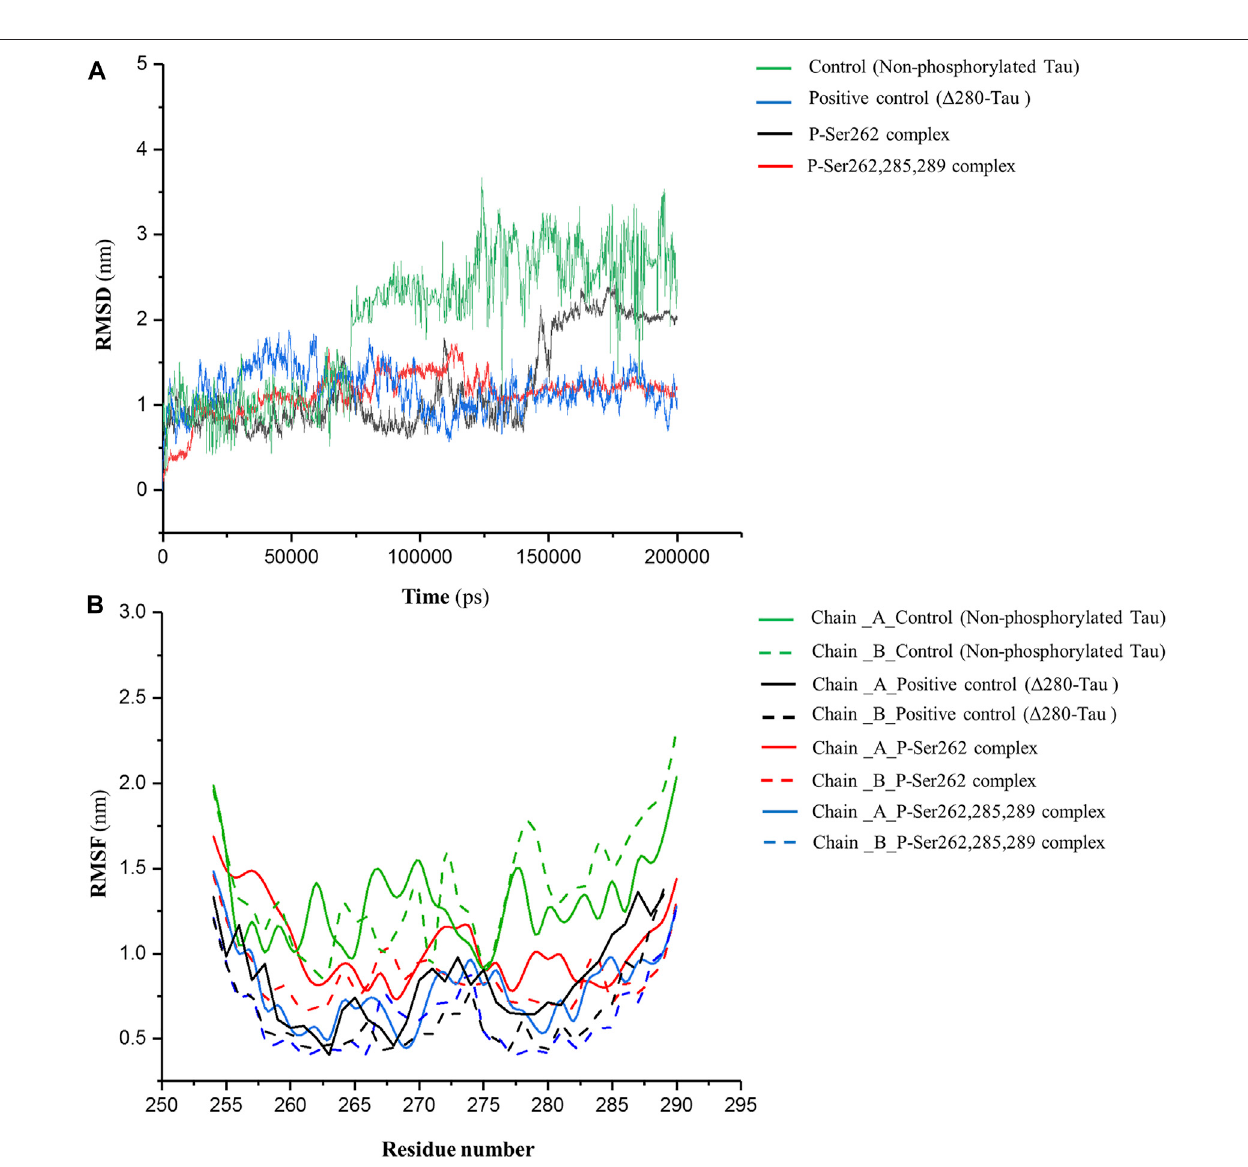
FIGURE 1 | RMSD of backbone and RMSF pro fi le for the control (non-phosphorylated tau), positive control ( Δ 280-tau), and the complexes with one (P-Ser262) and three (P-Ser262, 285, and 289) phosphorylation sites during 200 ns simulations. (A) RMSD plots representing the stability of the complexes and (B) RMSF of residues show each strand ’ s fl